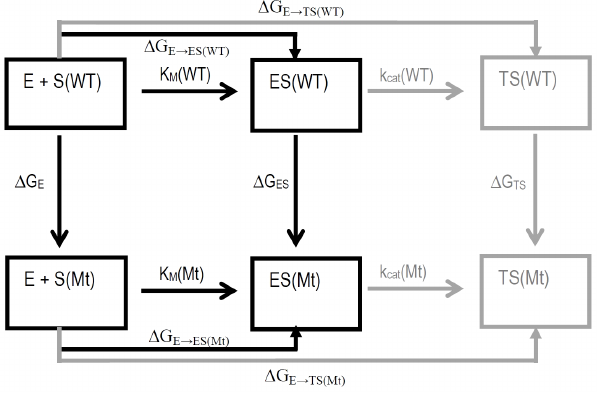
Figure 2. Relationship between free energy changes for the phosphorylation of Kemptide (WT) and mutants (Mt) catalyzed by PKA. E represents the free enzyme, S(i) is the free substrate, ES(i) represents the enzyme-substrate complex, and TS(i) represents the transition state.